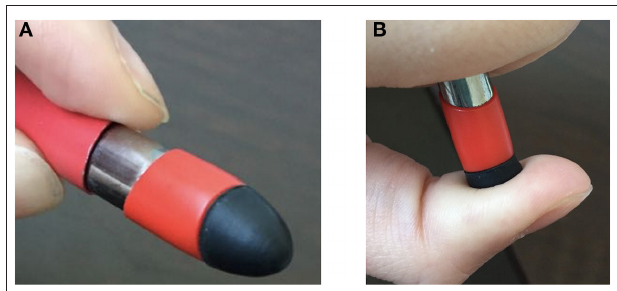
FIGURE 1 | The instrument used to explore referred sensations (RS) by stimulating different areas with the soft rubber tip (A) , pressing on the skin (B) . The participant reported RS during intense